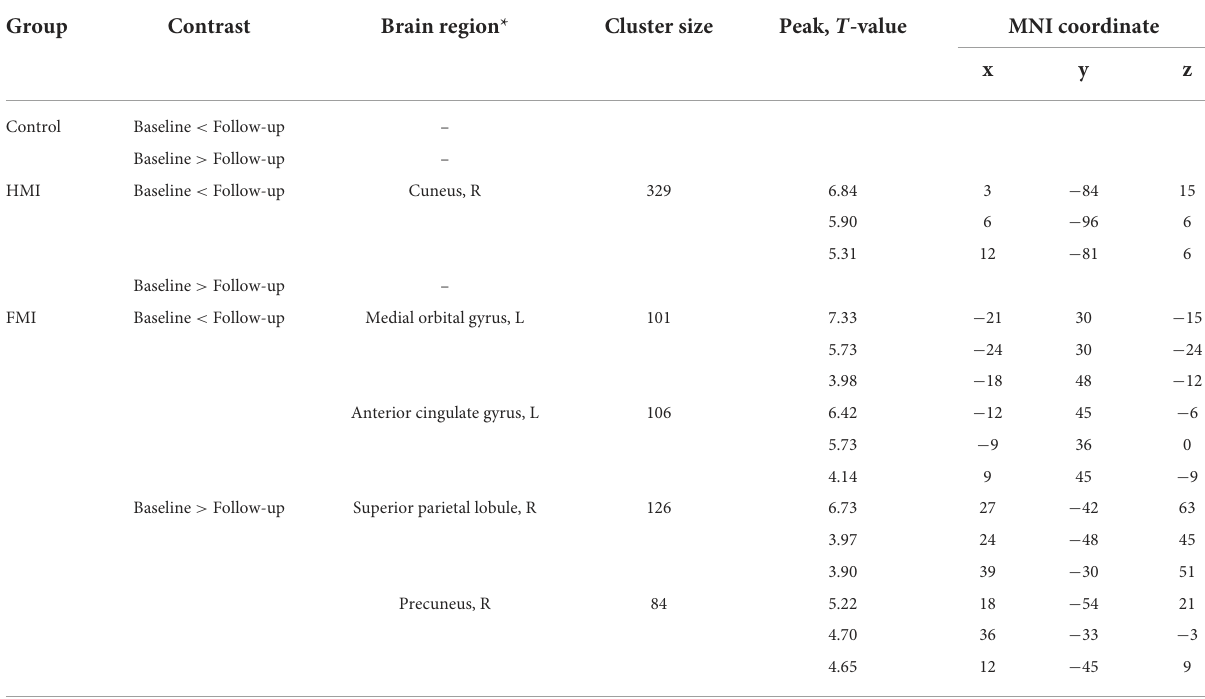
TABLE 3 Brain regions with significant longitudinal changes in